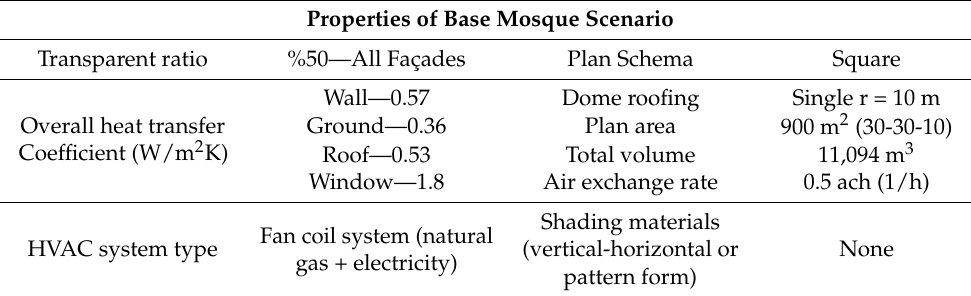
Table 1. The physical properties and HVAC system data of the base mosque scenario.